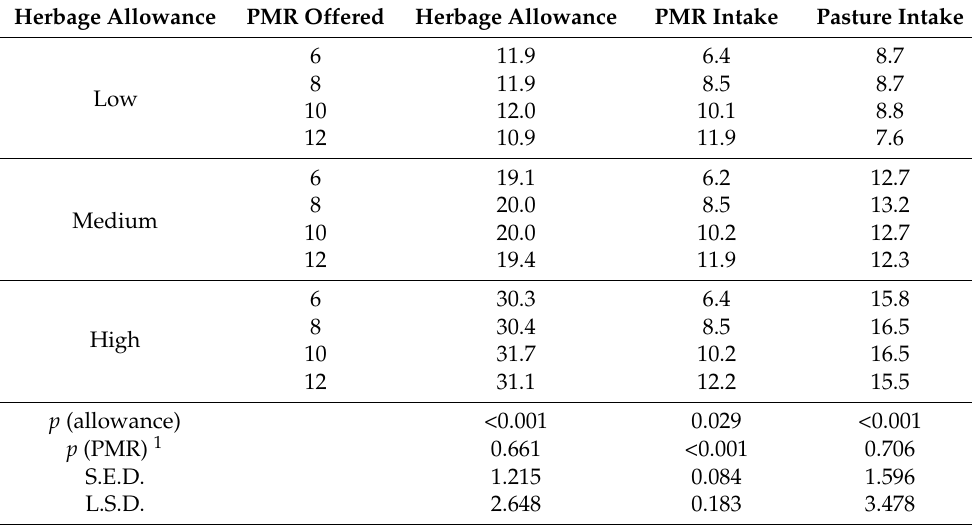
Table 3. Dry matter intake (kg DM/cow per day) from pasture and supplement for cows in late lactation offered a low, medium and high herbage allowance (kg DM/cow per day) and offered a partial mixed ration (PMR) at nominal amounts of 6, 10, 12 or 14 kg DM/cow per day. Data are means from the 14-day measurement